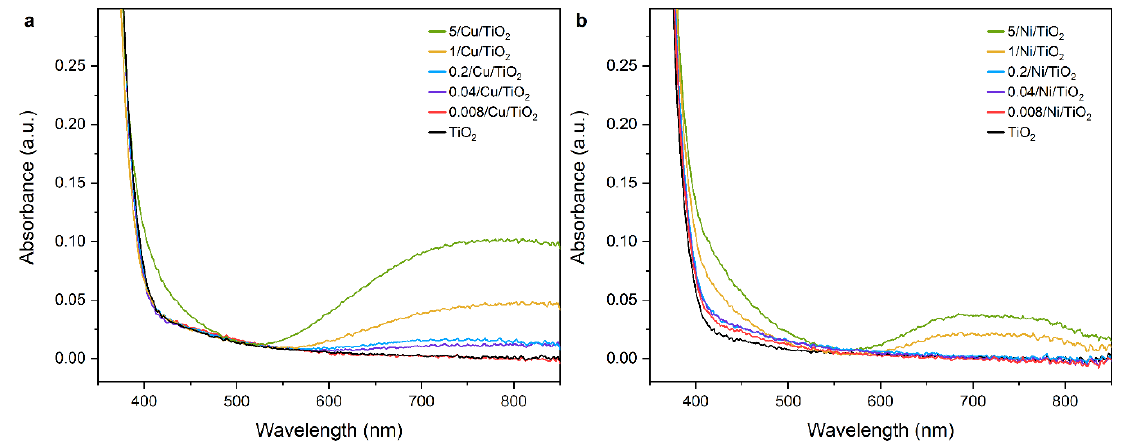
Figure 3. Absorbance spectra obtained through DRS measurements of ( a ) Cu/TiO 2 and ( b ) Ni/TiO 2 composite series.